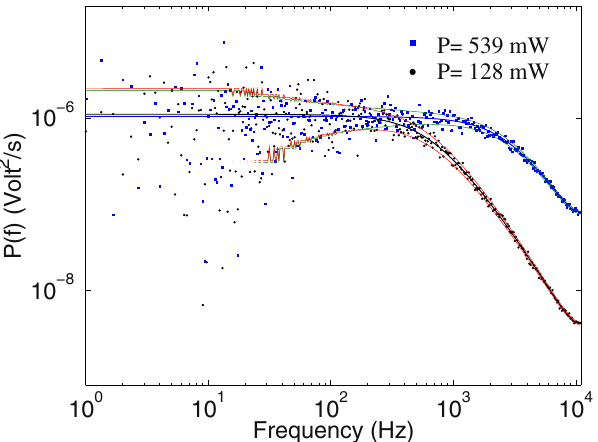
Figure 2. The power spectra of a trapped spherical polystyrene bead. Typical power spectra of a spherical polystyrene bead of diameter ~1 μ m, trapped by using laser powers of 128 mW and 539 mW. The solid lines represent fits to Eq. (4), with one σ confidence intervals using the calibration program of ref. 7. The time series x ( t ) for the spatial positions were recorded with sampling rate of 22